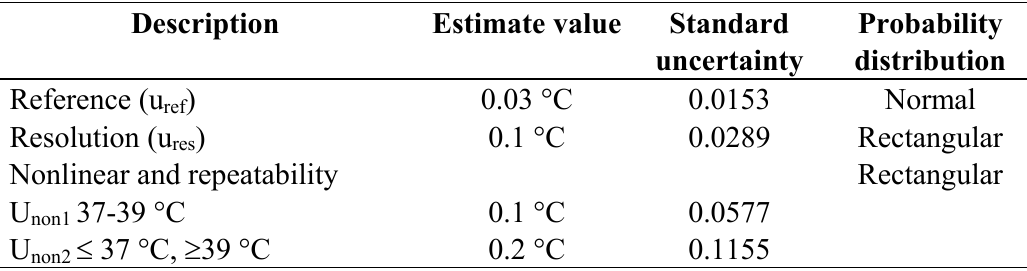
Table 6. The type B uncertainty analysis for BRAUN IRT-3020 thermometer.